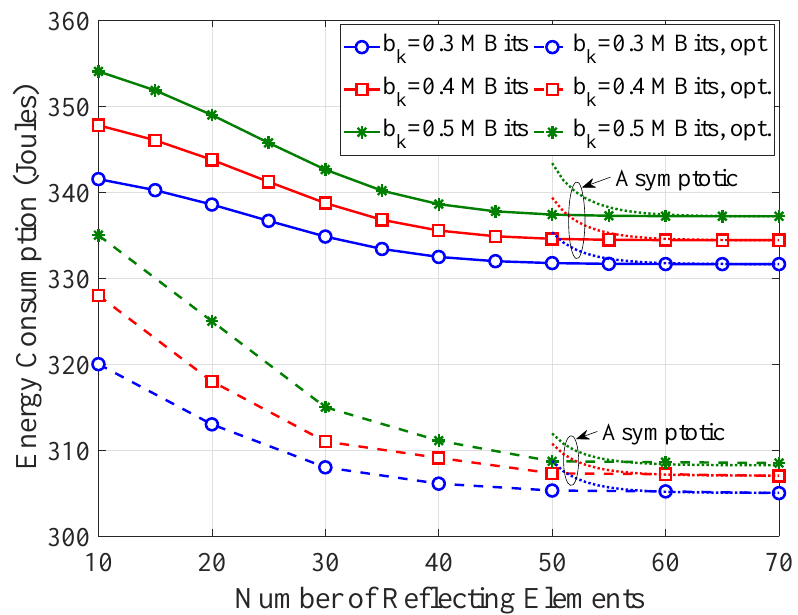
Figure 5. The non-optimized and optimized weighted total energy consumption (WTEC) as a function of the number of reflecting elements for varying task requirement.